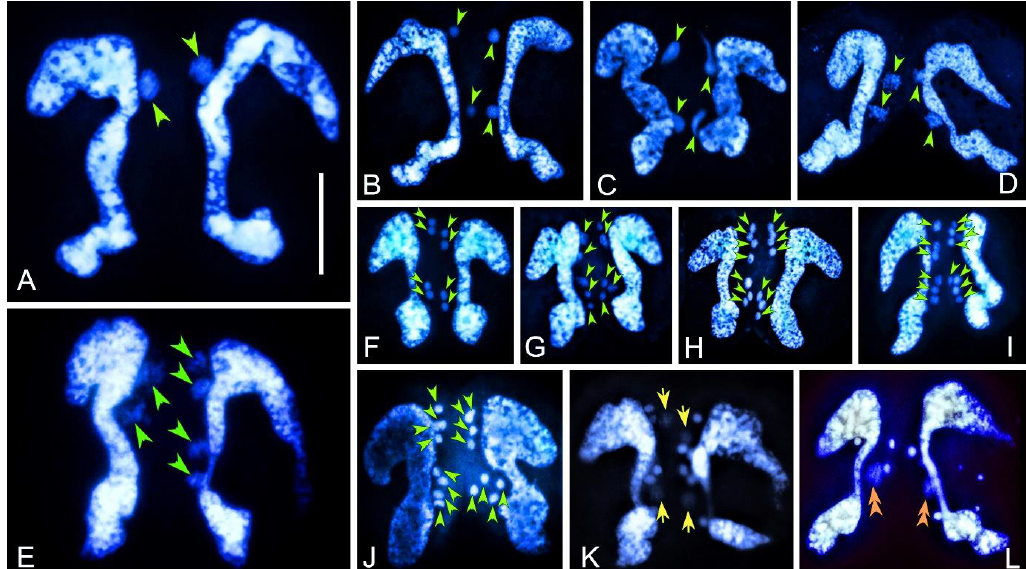
Figure 1. Nuclear events in conjugating pairs of Euplotes raikovi after Hoechst 33342 staining. ( A ) At the beginning of conjugation, the micronucleus (MIC) of each mating cell swells and migrates out of the concavity of the macronucleus (MAC). ( B ) After the first prezygotic division of the MIC. ( C – F ) Various stages of the first meiosis division. Cells in ( C ) is the zygotene stage of the first meiosis: the chromatin polymerizes into a typical ‘bouquet’ shape. In ( E ), cells have different numbers of nuclei due to asynchronous division. ( G – J ) Mating cells during the second meiotic division with different numbers of nuclear products due to asynchronous division. In ( J ), end of the second meiotic division results in eight haploid nuclei. ( K ) In each cell, two pronuclei (indicated by yellow arrows) swell while the other nuclei degenerate. ( L ) Synkaryon formation after exchange and fusion of pronuclei (orange double-arrowheads). Green arrowheads indicate nuclei derived from prezygotic divisions; yellow arrows indicate the pronuclei; orange double-arrowheads indicate the synkaryon. Scale bar = 20 μm.